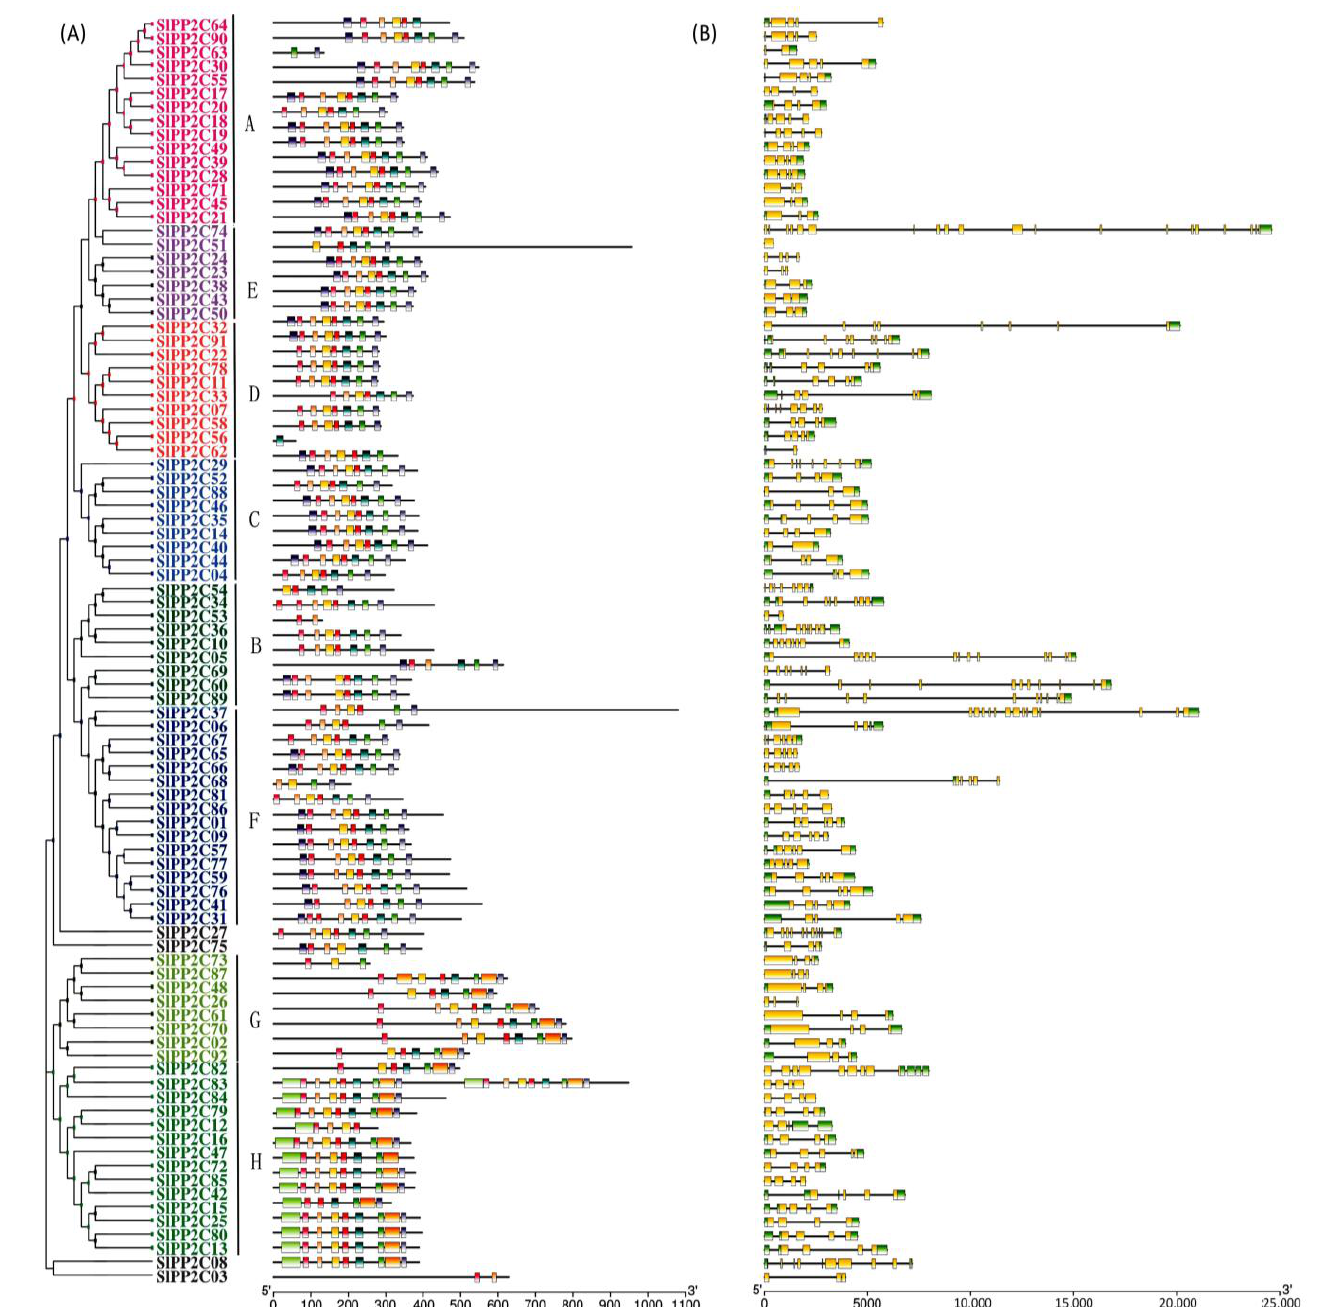
Figure 4. Phylogenetic relationships, conserved motifs of SlPP2C proteins, and structures of SlPP2C genes in tomato. ( A ) Arrangement of conserved motifs in SlPP2C proteins. Ten predicted motifs were represented by different colored boxes, and motif details referred to Table 3. A-H depicted that PP2C genes were divided into eight groups. Scale bar indicates amino acid length ( B ) Gene structure of SlPP2C members. The phylogenetic tree was constructed using MEGA-X software and the gene structures were visualized by TBtools. Boxes represented exons, and yellow boxes represented CDS and the upstream and downstream regions of SlPP2C genes were indicated by green boxes. For all genes, black lines represent introns. The sizes of genes can be estimated by the scale at the